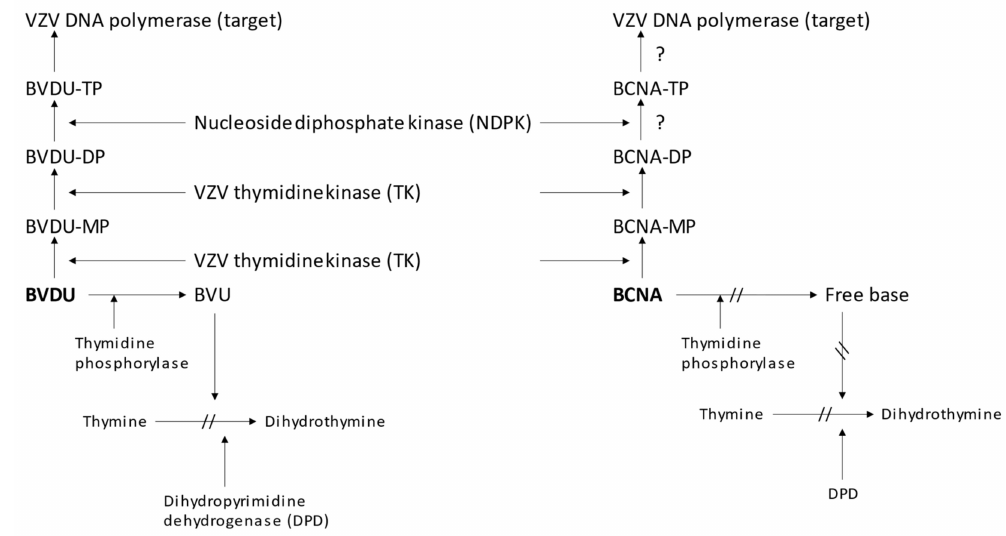
Figure 3. Anabolic and catabolic steps involved in the metabolism of BVDU and